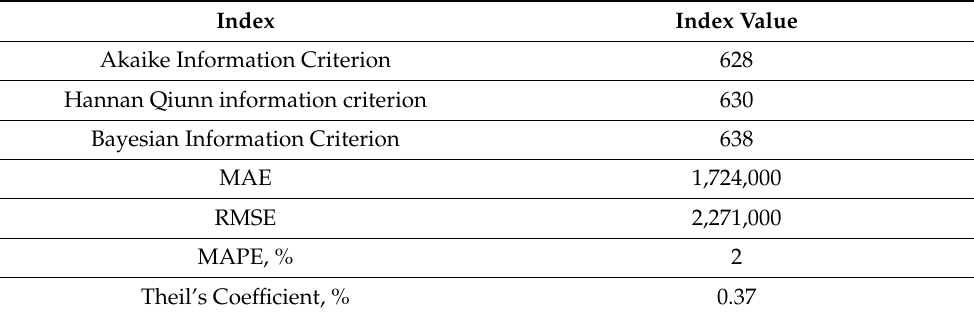
Table 1. Parameters of the ARMAX (0,1,1) model.